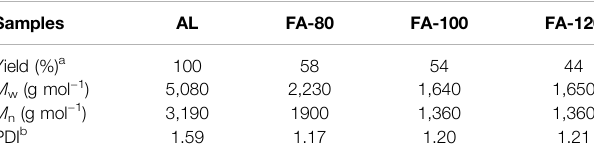
TABLE 1 | Recovery yield of regenerated lignin samples and molecular weight of the lignin.